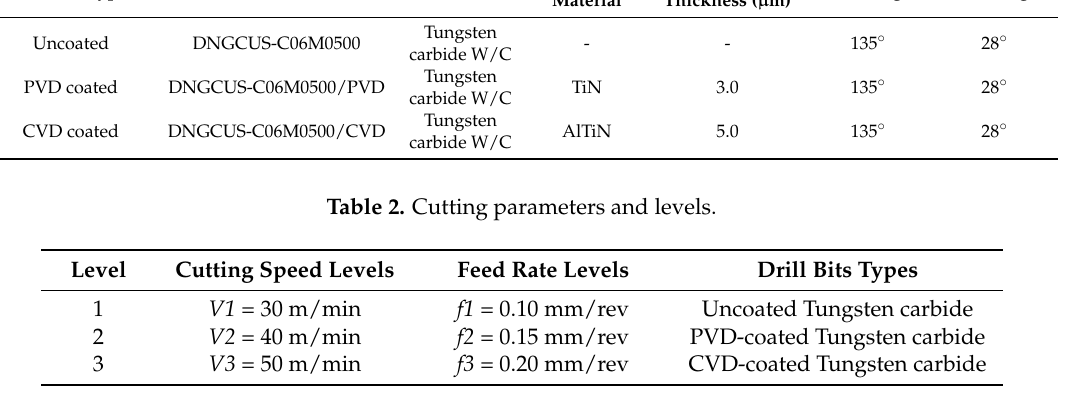
Table 3. L 27 (3 3 ) Taguchi’s orthogonal array design for